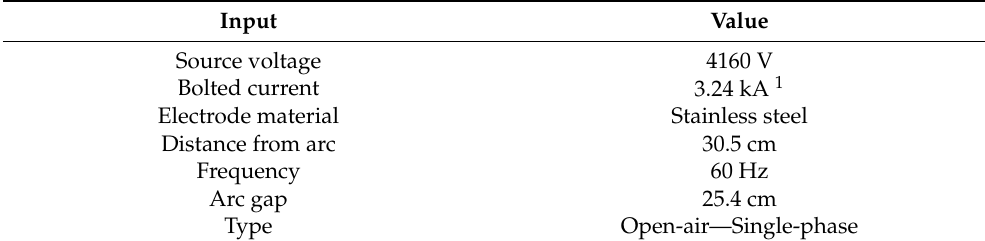
Figure 4. Data input screen for ArcPro simulation—Case study 1. Table 2. Relation of input data for ArcPro simulation—Case study 1.